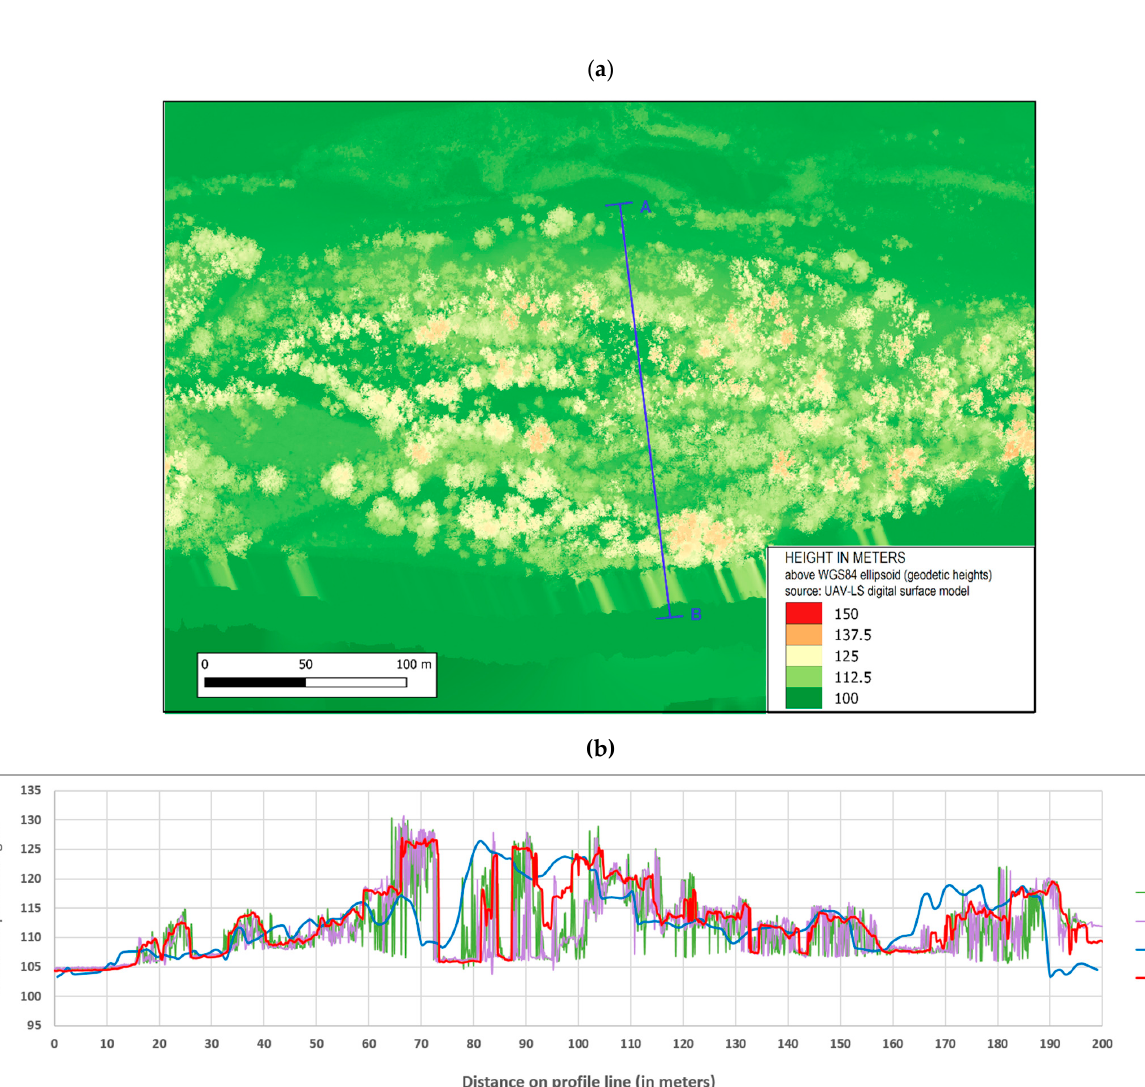
Figure 15. ( a ) Northern Island and Vistula riverbed cross-section used to make the pro fi le graph, ( b ) Northern Island—comparison of four digital surface models (DSMs) based on di ff erent data sources (UAV-LS, ALS, UAV-DAP, PLEIADES). The measurement values are in metres, WGS84 ellipsoidal (geodetic heights).